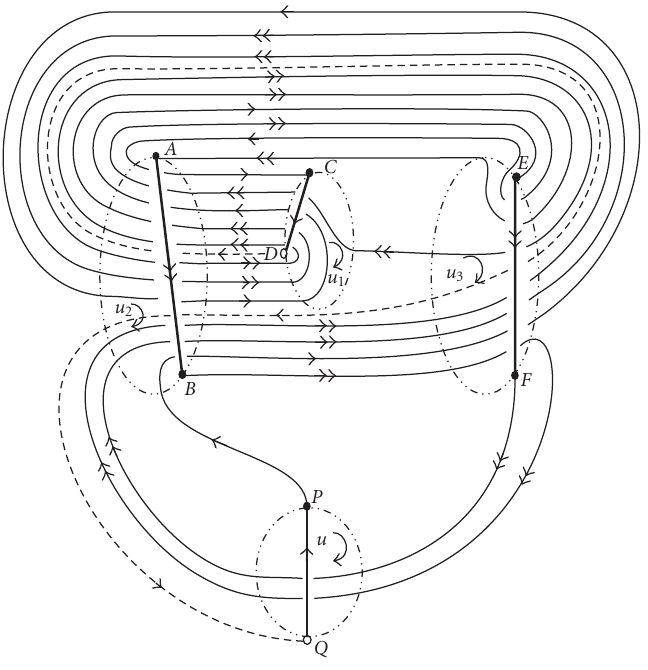
Figure 4.2. The branch set arising from the 2-symmetric diagram of Im and